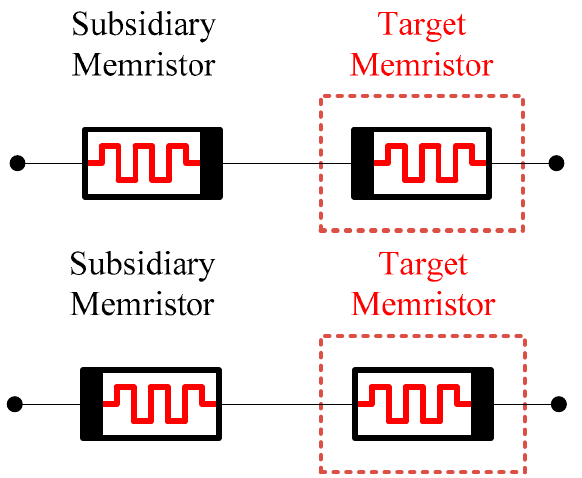
Figure 7. Proposed linearized programming method with anti-serial architecture. It is a circuit of two memristors in serial connection with opposite polarities. Though the individual behavior of memristance variation of two memristors is nonlinear about time, it becomes linear in an anti-serial connection due to the complementary action of two memristors with opposite polarities.